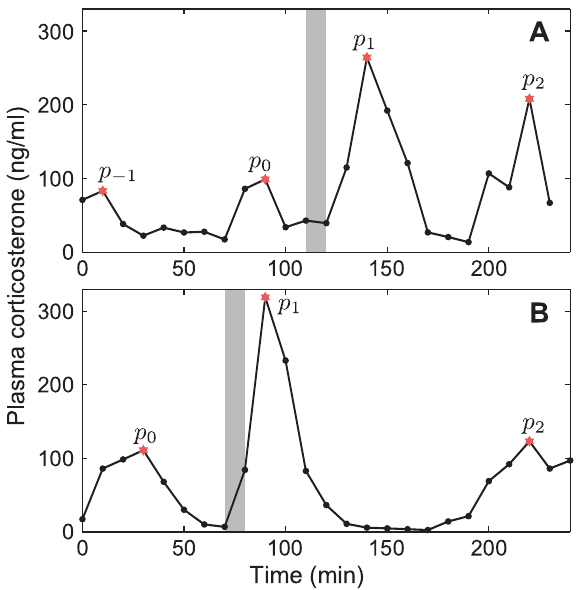
Figure 5. Parameter dependent profiles of phase response curves. (A) Phase response curves (PRCs) for different values of the stress impulse amplitude L as indicated. For L v 2 the model exhibits Type 1 phase-resetting (grey curves) with a sharp but continuous change in phase near w C ~ 0 : 2 . For L w 2 the model exhibits Type 0 phase-resetting (black curves) with a discontinuous change in phase near w C ~ 0 : 2 . (B) Type of PRC curve plotted against L .